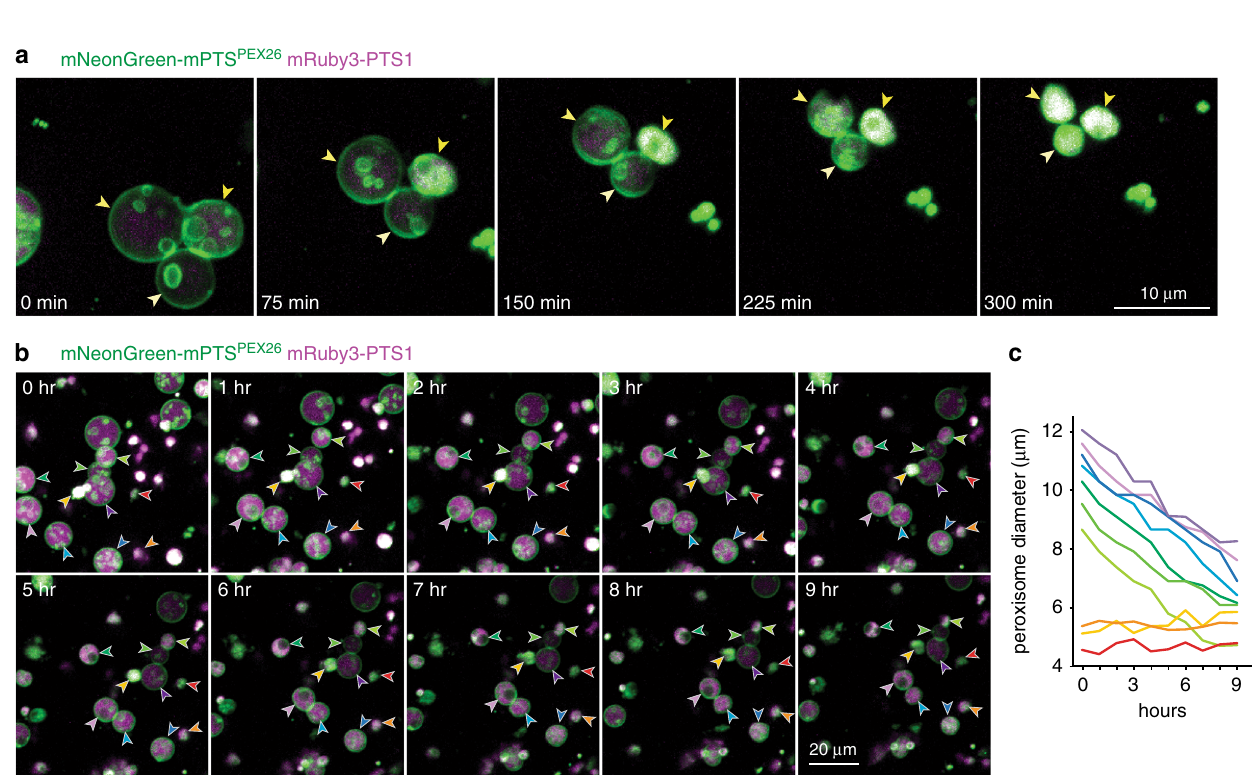
Fig. 2 Peroxisome size decreases as inner membrane density increases. a , b Z -projections of cotyledon epidermal cells of a 4-day-old seedling expressing mNeonGreen-mPTS PEX26 (green) and mRuby3-PTS1 (magenta) imaged with high-magni fi cation spinning disk confocal microscopy over 5 h ( a ) or lower- magni fi cation scanning confocal microscopy over 9 h ( b ). Individual peroxisomes are designated with differently colored arrowheads. c Diameters of individual peroxisomes marked with arrowheads of same color in panel ( b